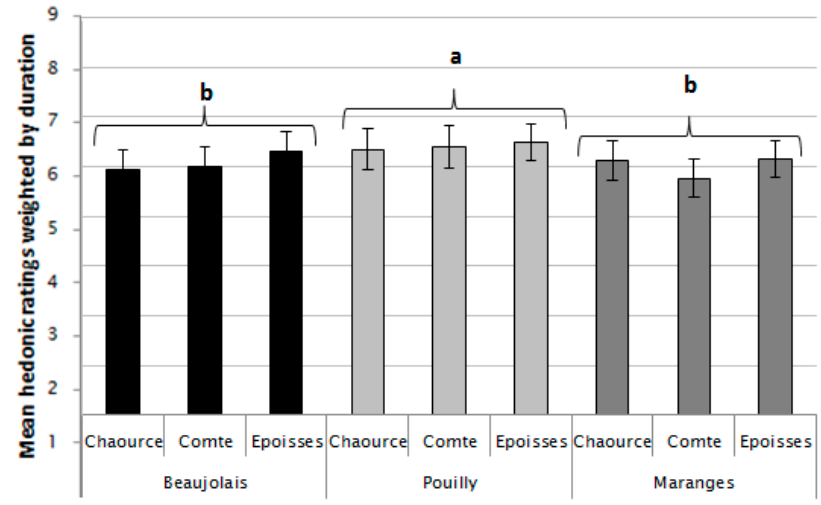
Figure 5. Weighted mean liking scores given to the combinations of wine and cheese evaluated over multiple intakes. Different letters represent significant differences ( p < 0.05) according to LSD test.